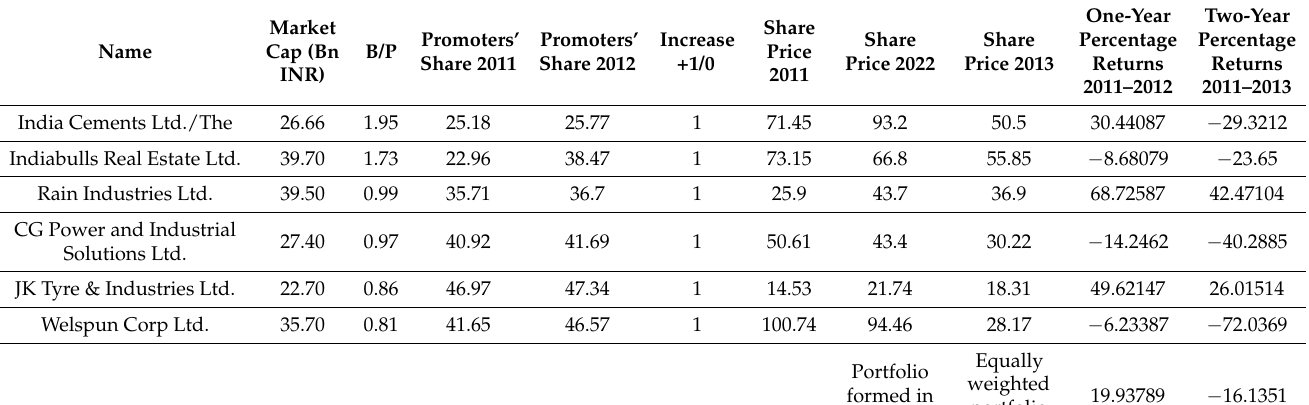
Table 1. Portfolio 2011 (financial details of small-cap companies whose promoter holdings increased in a year).